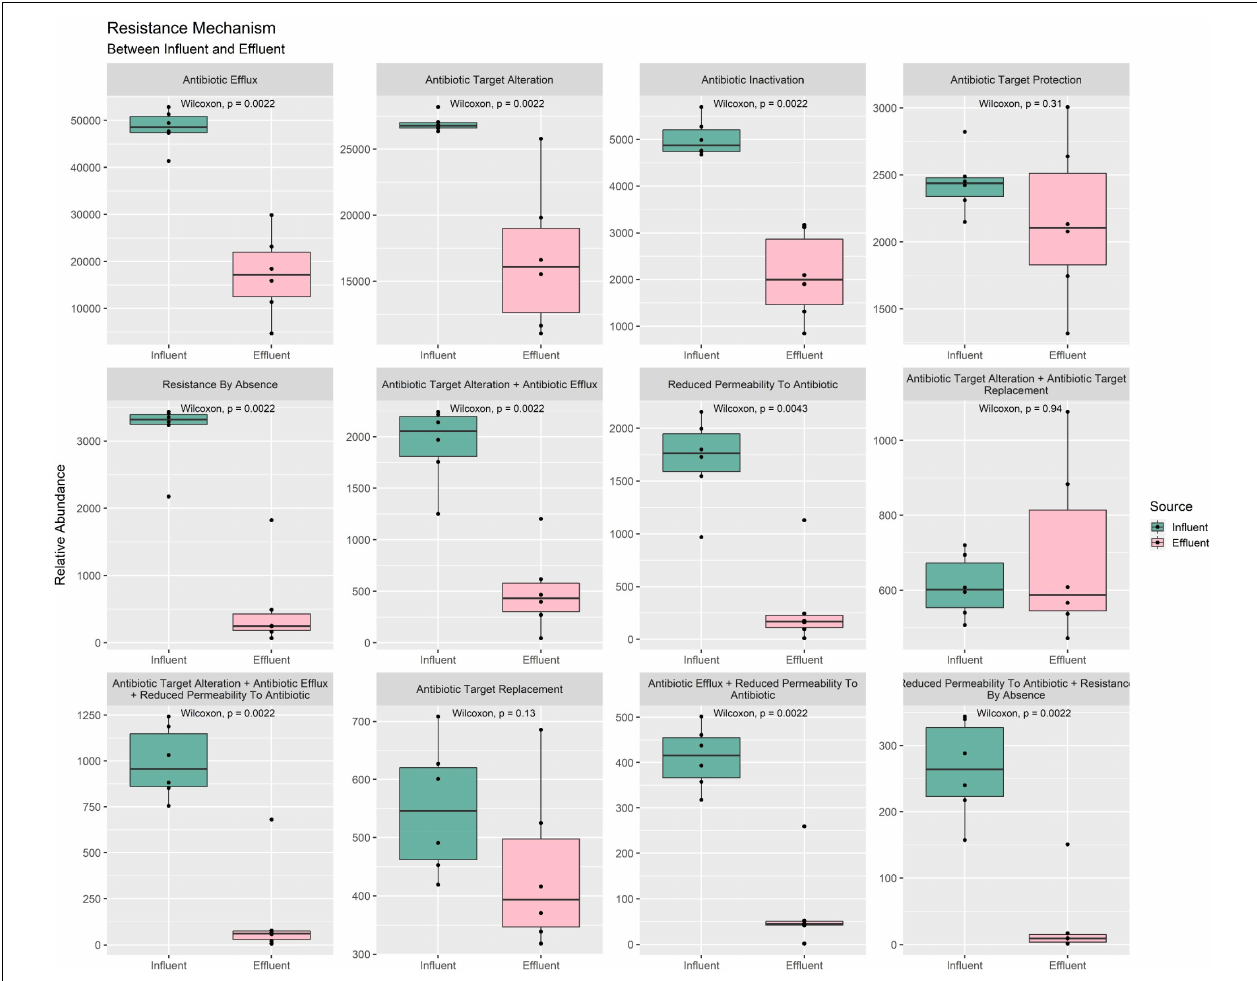
FIGURE 7 | Box plots of the ARG resistance mechanism phenotype between influent and effluent